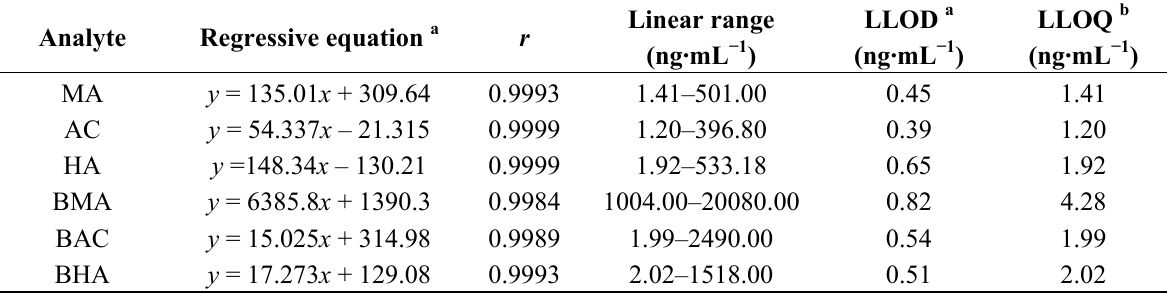
Table 3. Regressive equation, linear ranges, LLODs, and LLOQs of the six analytes.